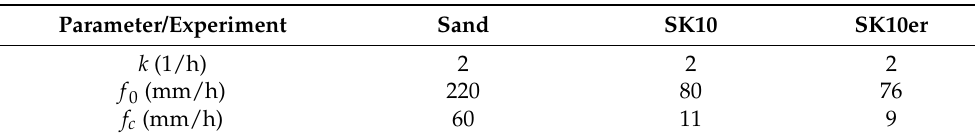
Table 11. Calibrated values of parameters for different experiments using the Horton method. Initial values are shown in Table